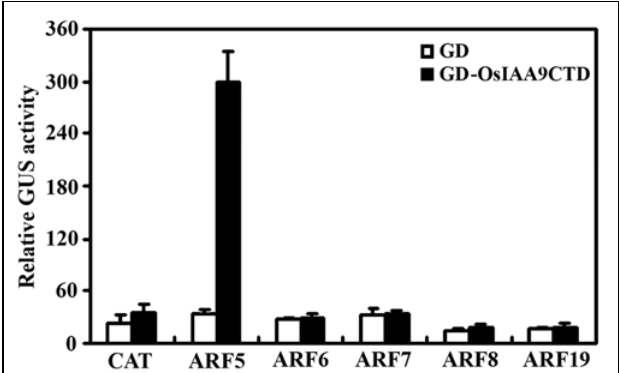
FIGURE 4 | OsIAA9 interacts with ARF5 in plant cells. Plasmids of effectors GD-OsIAA9CTD and ARFs , and reporter Gal4:GUS were co-transfected into protoplasts and incubated for 20–22 h, then GUS activity was assayed. Data represent the mean ± SD of three replicates.